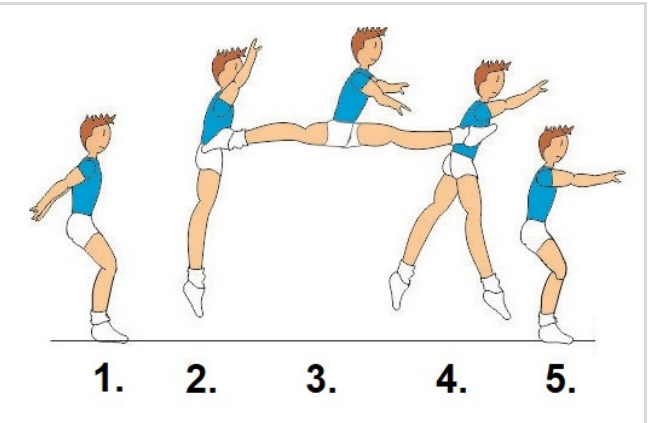
Figure 2. Split jump: 1. approach; 2. take off; 3. culmination; 4. descent; 5. landing.